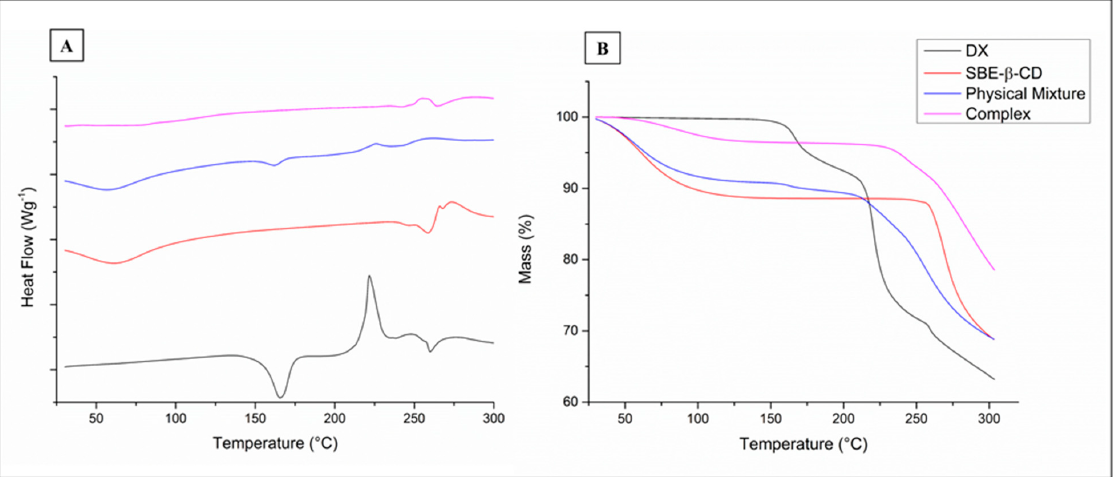
Figure 6. DSC ( A ) and TGA ( B ) thermograms of doxycycline, sulfobutylether- β -cyclodextrin (SBE- β -CD), physical mixture (1:1), and the DX/SBE- β -CD (1:1) complex.